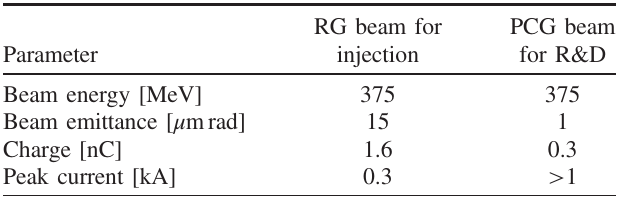
TABLE I. Parameter for APS linear accelerator. Parameter